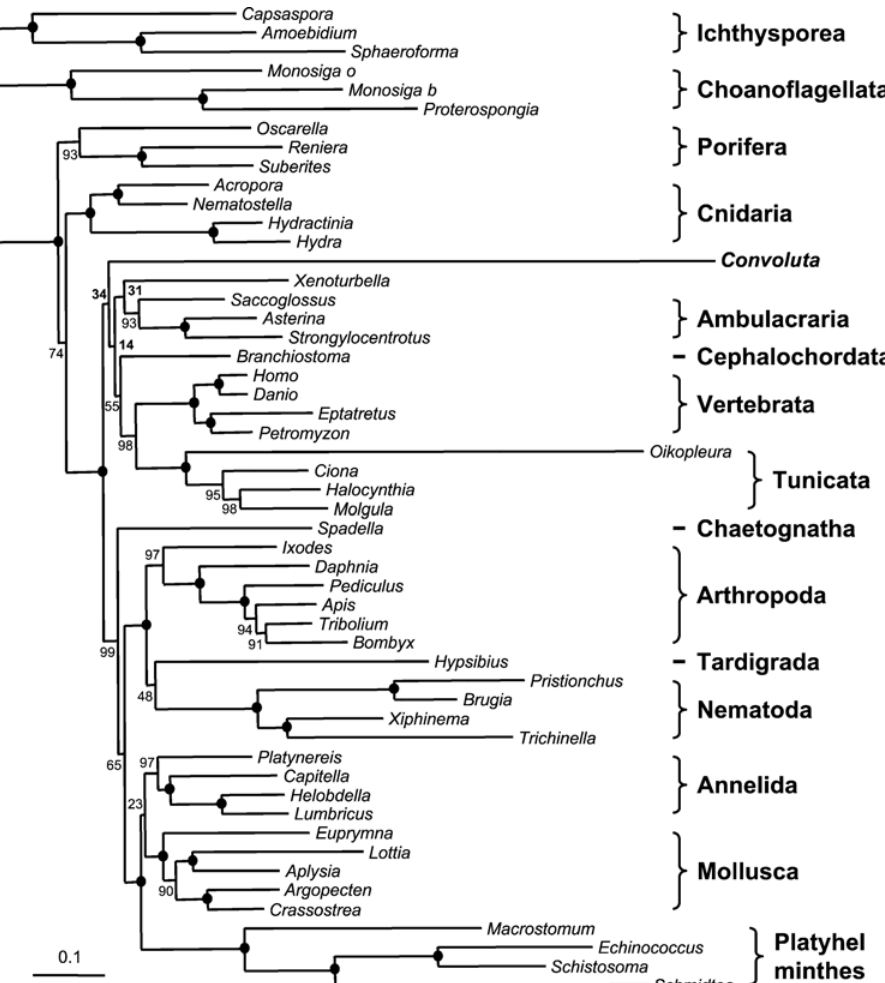
Figure 1. Phylogenetic analysis of genomic data strongly rejects the grouping of Convoluta and Platyhelminthes. Bayesian tree obtained from the analysis of 11,959 aligned amino-acid positions with the CAT model. Bootstrap values obtained are indicated when , 100%, otherwise a bullet is present on the node. The scale bar indicates the number of changes per site.